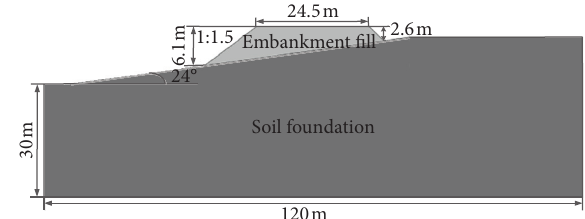
Figure 4: Embankment